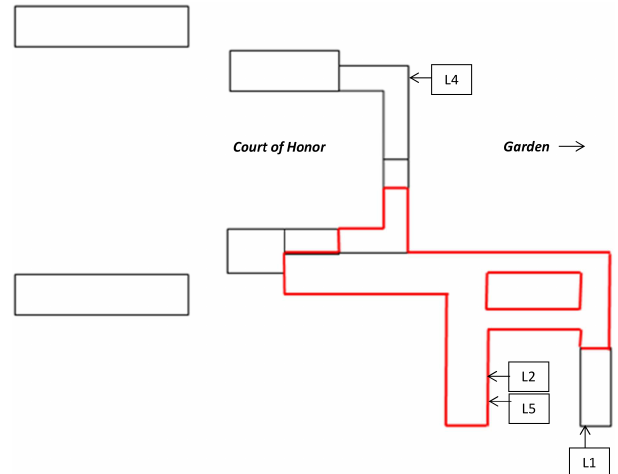
Figure 3. Sketch of the Lunéville château with the original location of blocks L1, L2, L4, and L5 – not presented here (Gatuingt, 2017): L1 was located in the frame of an opening on the ground floor of the edifice, L4 in the frame of a second floor window, and L2 and L5 on the same balustrade on the first floor, a few blocks apart from each other. The zone in red represents the zone affected by the 2003